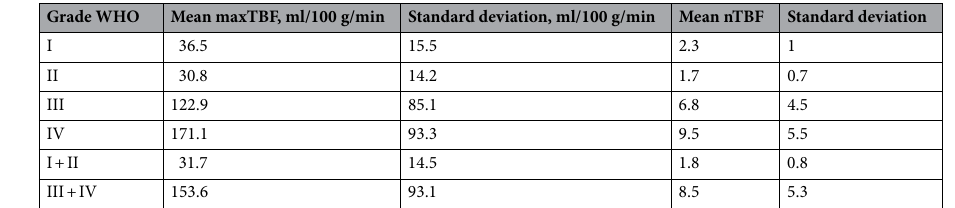
Table 2. Maximum absolute and normalized TBF values in gliomas of different grades.